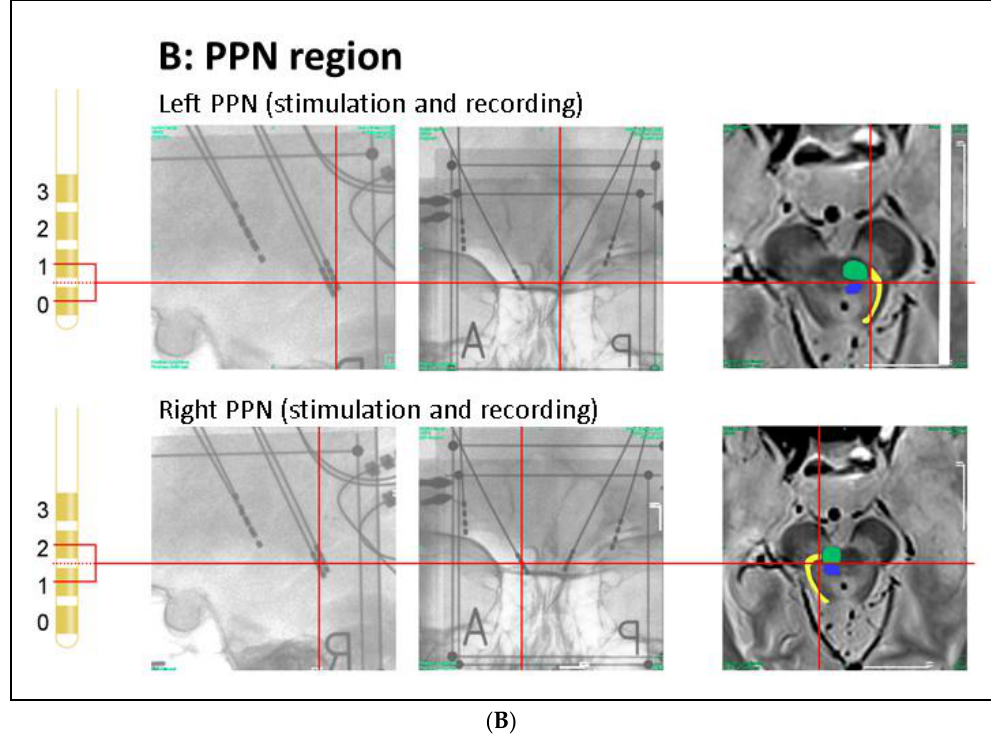
Figure 1. Anatomical positions of DBS electrodes. ( A ) Anatomical location of the GPi electrodes as determined by intra-operative orthogonal x-ray imaging: in the lateral and frontal x-ray views, the location of each contact used for stimulation or recording is marked by a red cross, as is the corresponding location in the proton weighted MRI (from left to right). Orthogonal x-ray images and intra-operative CT were acquired with stereotactic image fiducials allowing for transformation into a common (stereotactic) coordinate system with a spatial mismatch between CT and x-ray coordinates of less than 1 mm (unpublished data). MRI images were transformed into this coordinate system by manual image registration to the CT data using anatomical landmarks. Contacts 0–2 of the left electrode and contacts 0 and 1 of the right electrode were located within the ventro–postero–lateral section of the respective GPi. Please note that LFP signals were recorded and analyzed both from electrode pairs 0–1 and 2–3 (during contralateral stimulation); ( B ) Anatomical location of the PPN electrodes: the PPN region is located lateral to the decussation of the superior cerebellar peduncles (green) and the central segmental tract (blue) and medial to the lemniscal systems (yellow) (see Zrinzo et al., 2008 for anatomical details). According to these landmarks, contacts 0–2 of the left electrode and contacts 1 and 2 of the right electrode were located within the respective rostral PPN. Abbreviations: